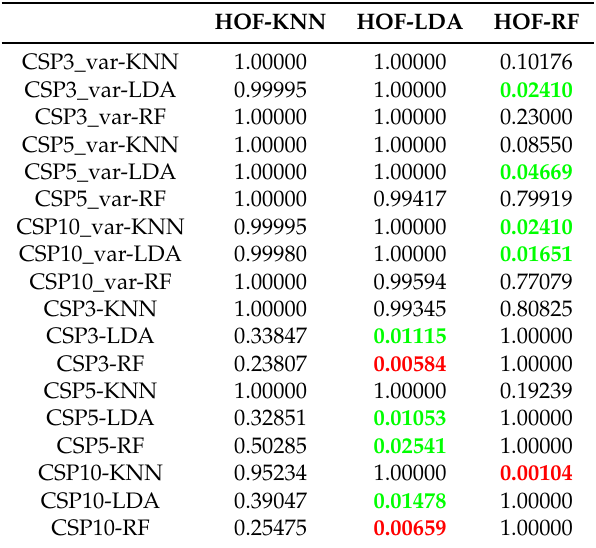
Table 6. Fridman Nemenyi post-hoc